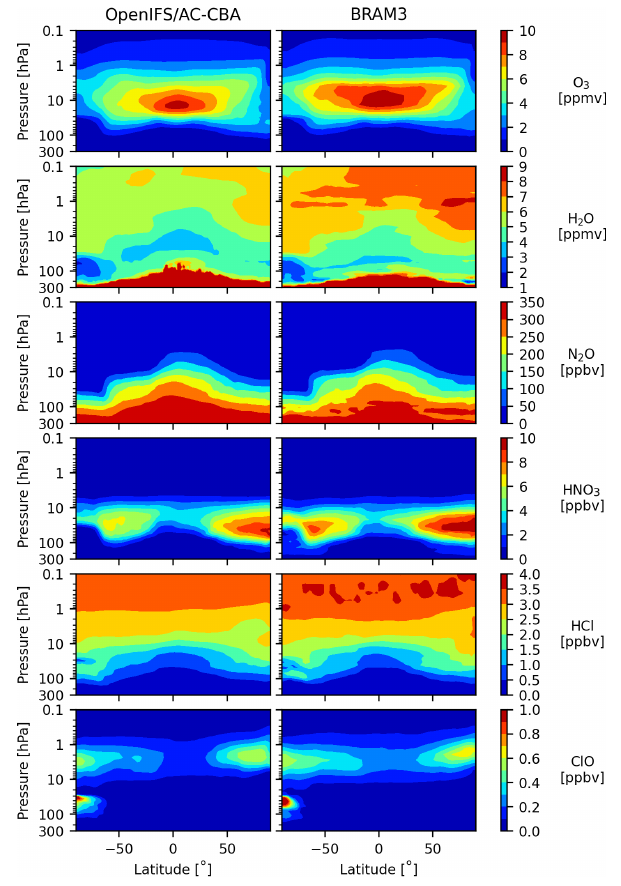
Figure 3. Latitude–pressure distributions of zonally averaged O 3 , H 2 O, N 2 O, HNO 3 , HCl, and ClO (from top to bottom) on 1 Octo- ber 2010 by OpenIFS/AC-CBA (left) and a BASCOE reanalysis of Aura MLS observations (right).